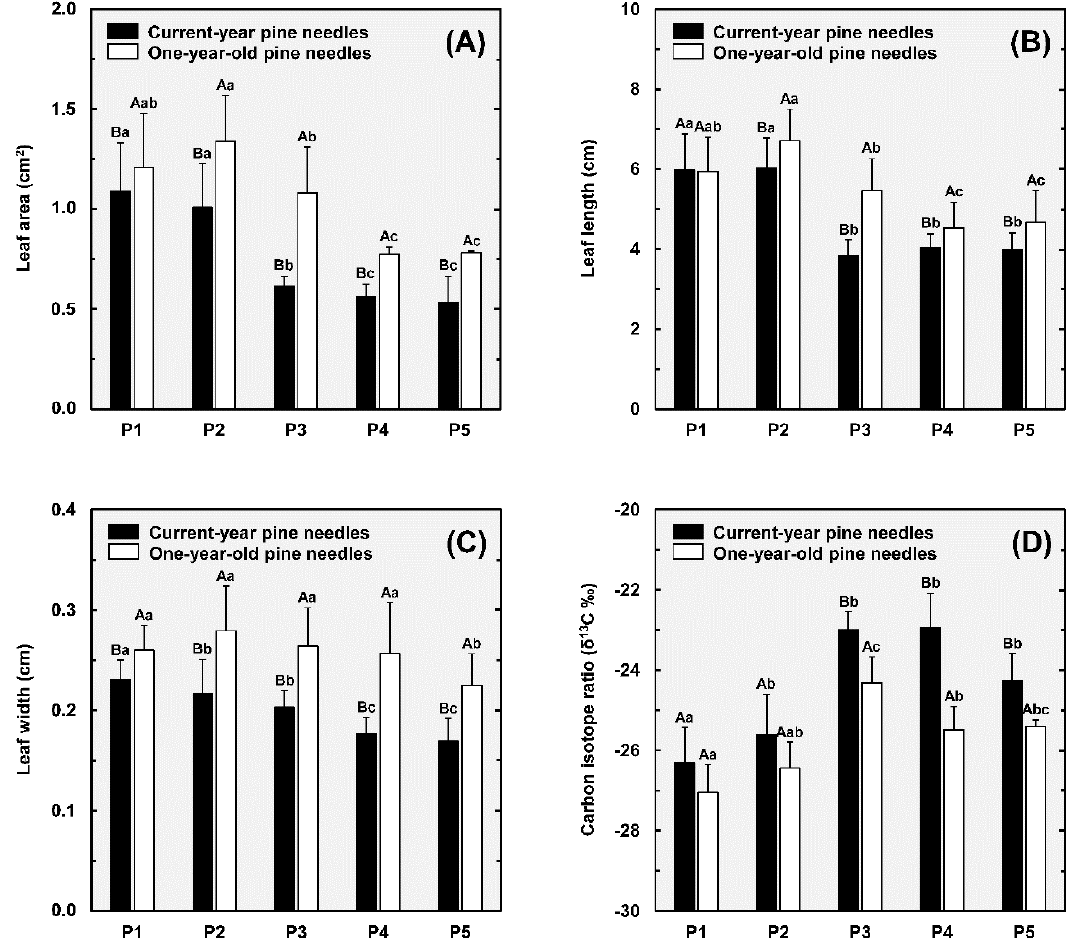
Figure 4. Comparison of Mongolian pine needle characteristics, i.e., leaf area ( A ), length ( B ), width ( C ), and carbon isotope ratios ( D ), according to changes in sand dune height. Values with different capital letters indicate significant differences between two needles age classes in each measurement point (Mann–Whitney test, p ≤ 0.05). Values with different small letters denote significant differences among five measurement points in each needle age class (Jonckheere–Terpstra test, p ≤